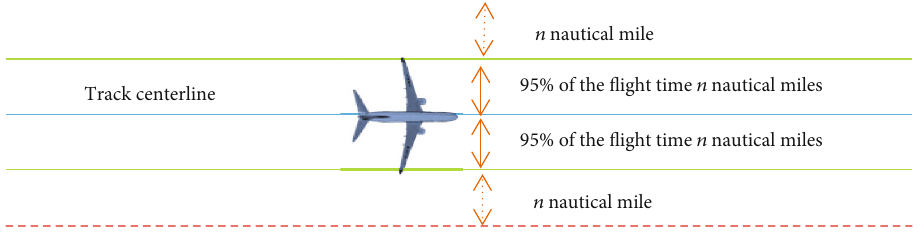
Figure 5: Schematic diagram of the RNP